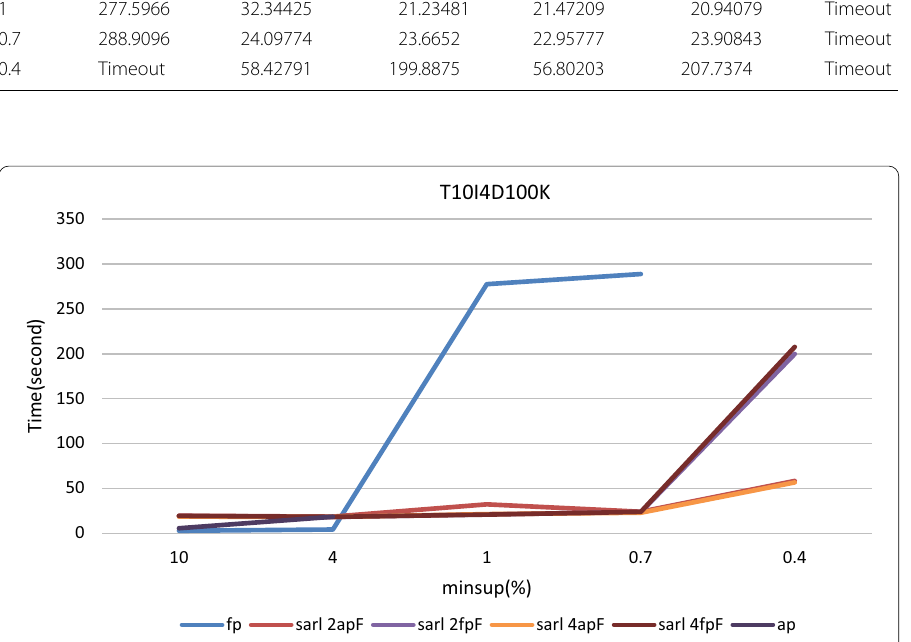
Fig. 8 Running times of different algorithms on the T10I4D100K